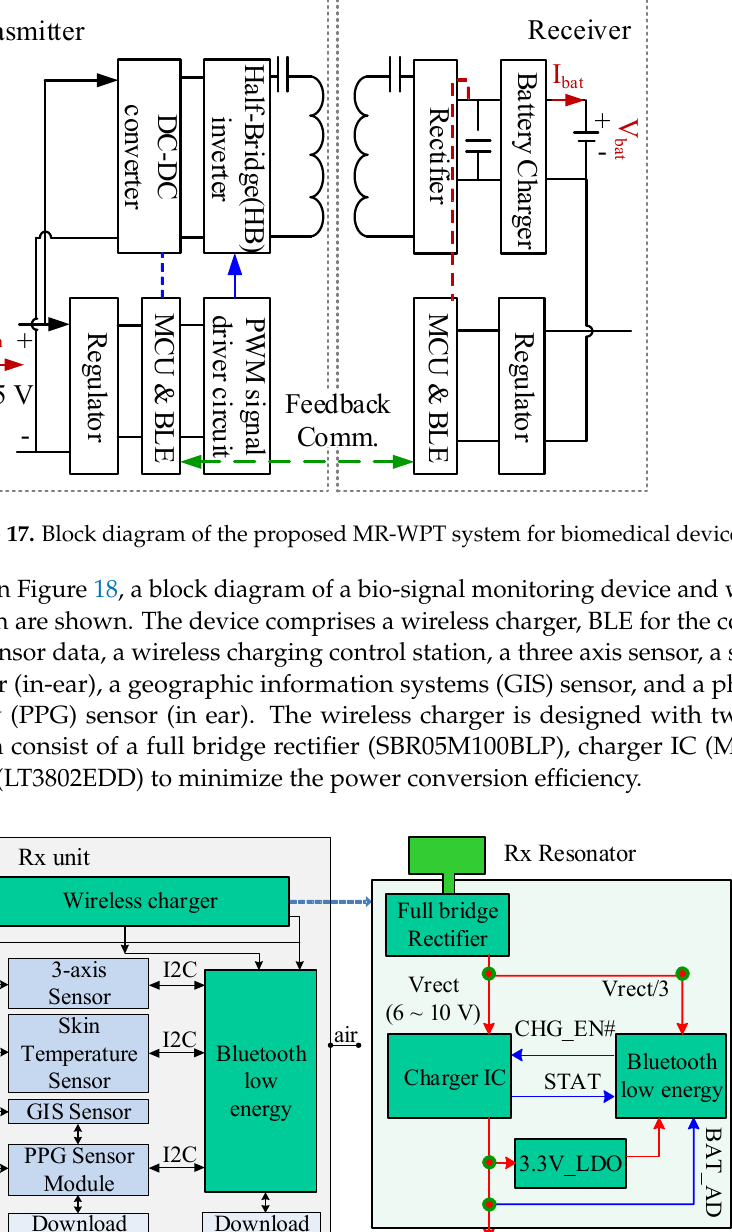
Figure 17. Block diagram of the proposed MR-WPT system for biomedical devices.